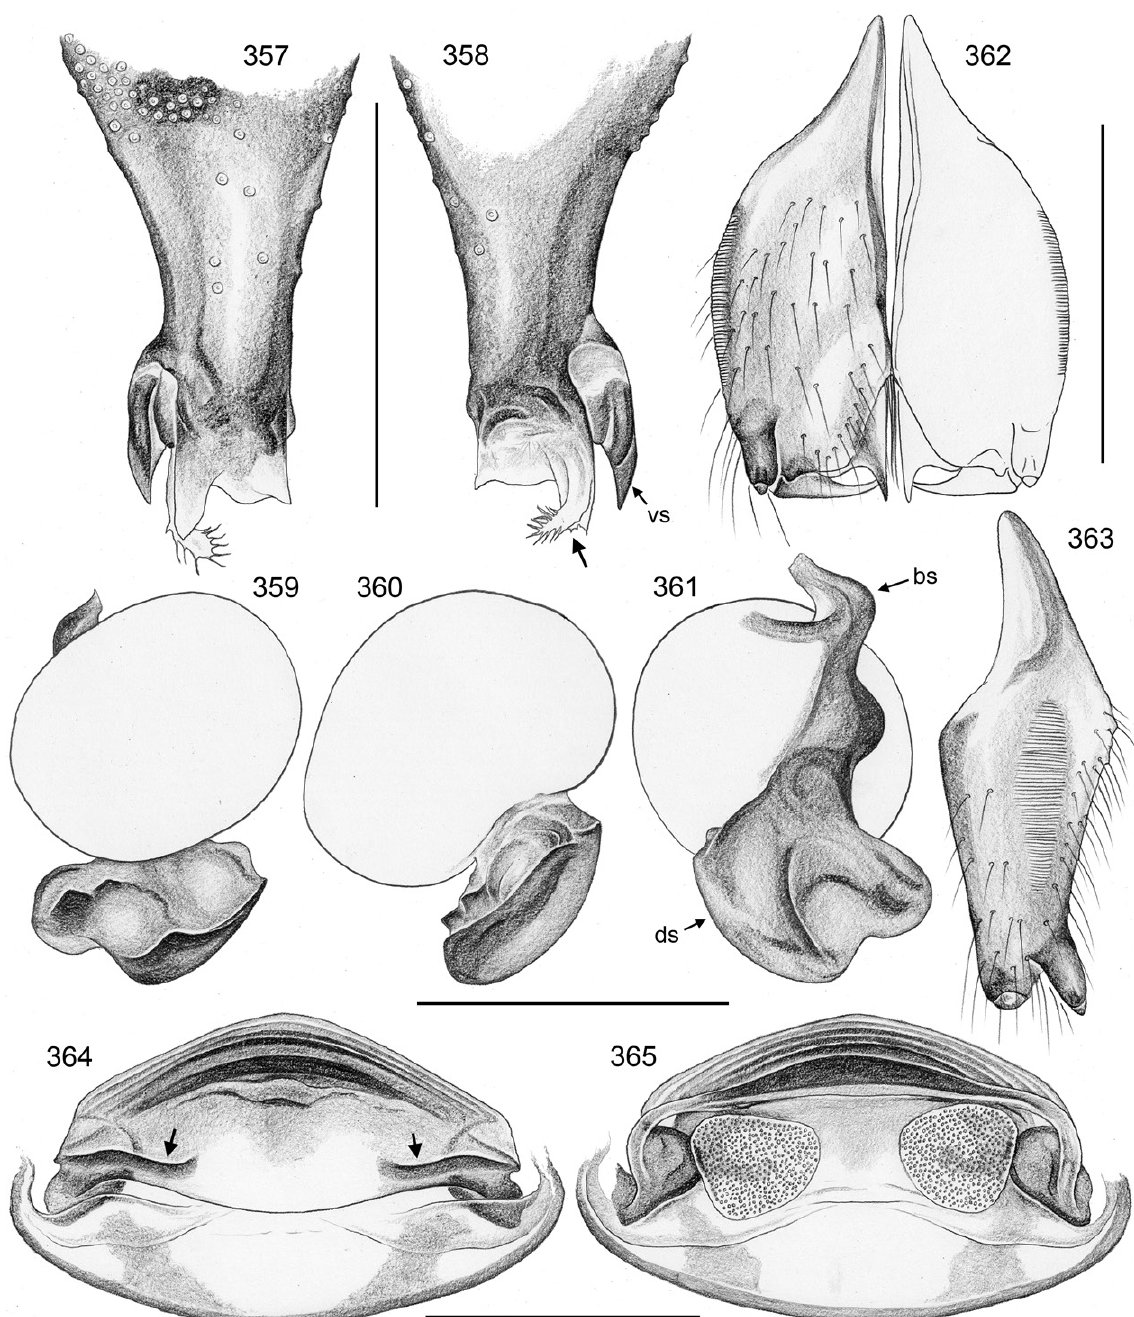
Figs 357–365. Crossopriza soudanensis Millot, 1941; lectotype male from Burkina Faso, Ouagadougou (MNHN Ar 10520), paralectotype female from Mali, Bamako (MNHN Ar 10512). 357–358 . Mirror images of right procursus, prolateral and retrolateral views; arrow: transparent process. 359–361 . Mirror images of right genital bulb, prolateral, dorsal, and retrolateral views. 362–363 . Male chelicerae, frontal and lateral views. 364–365 . Cleared female genitalia, ventral and dorsal views; arrows: pockets. Abbreviations: bs = basal sclerite; ds = distal sclerite; vs = ventral sclerite. Scale bars = 0.5